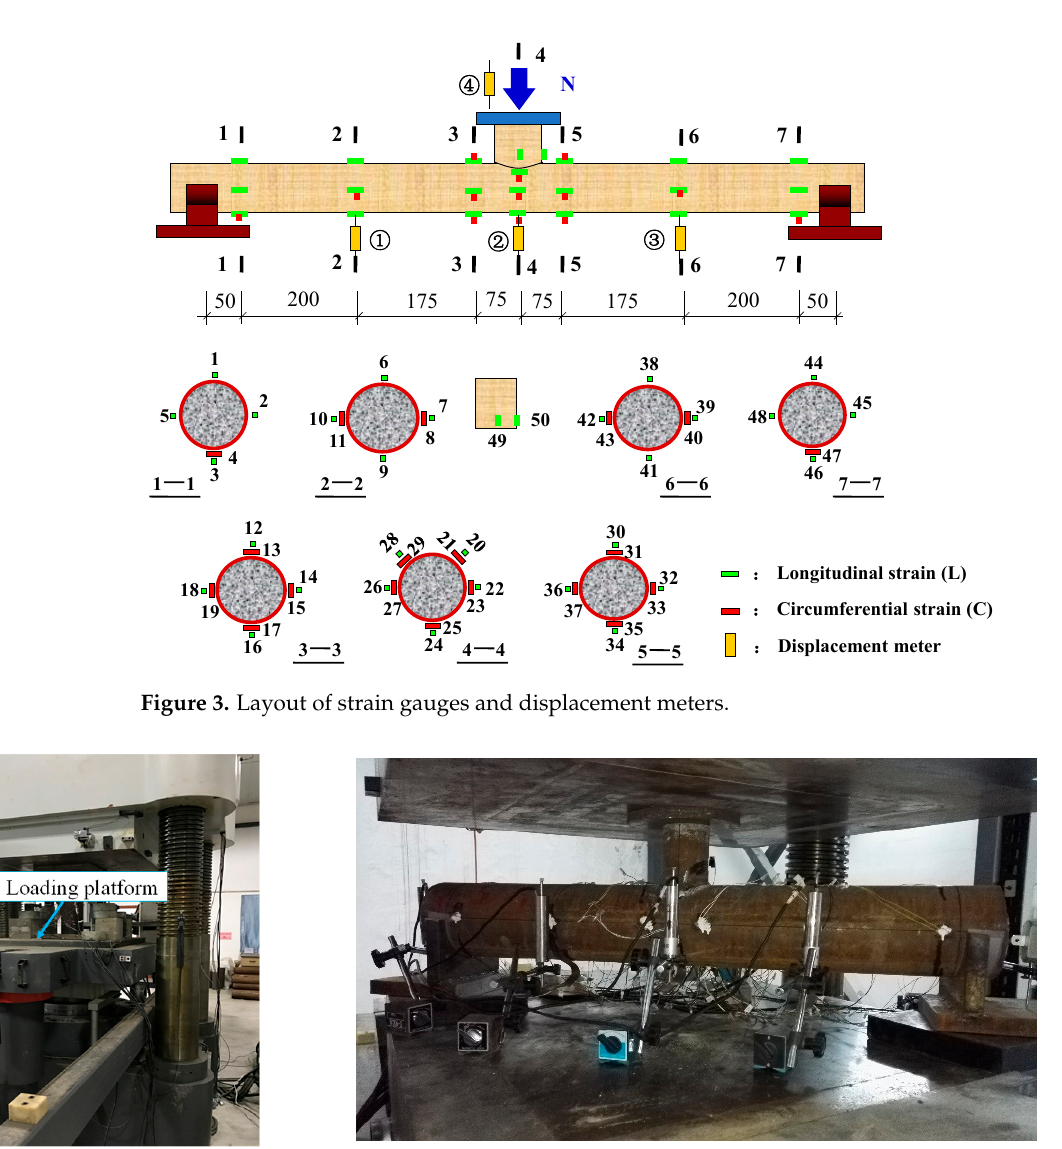
Figure 4. Layout of loading platform.